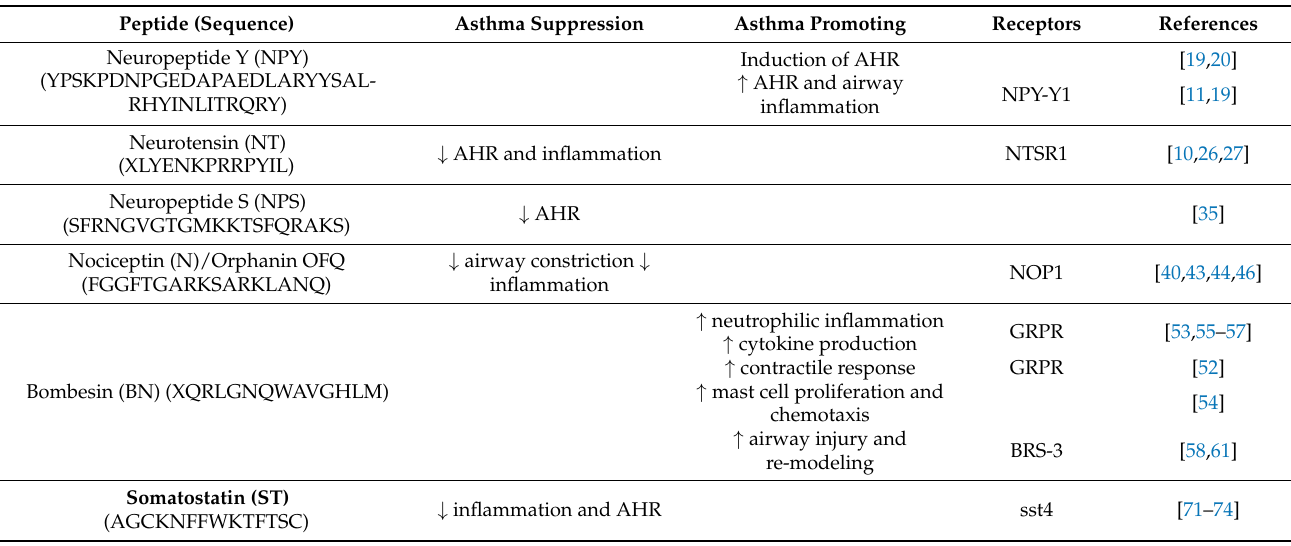
Table 1. Regulatory peptides involved in mediating asthma symptoms. A description of the action of a particular peptide and the receptors through which it acts (animal